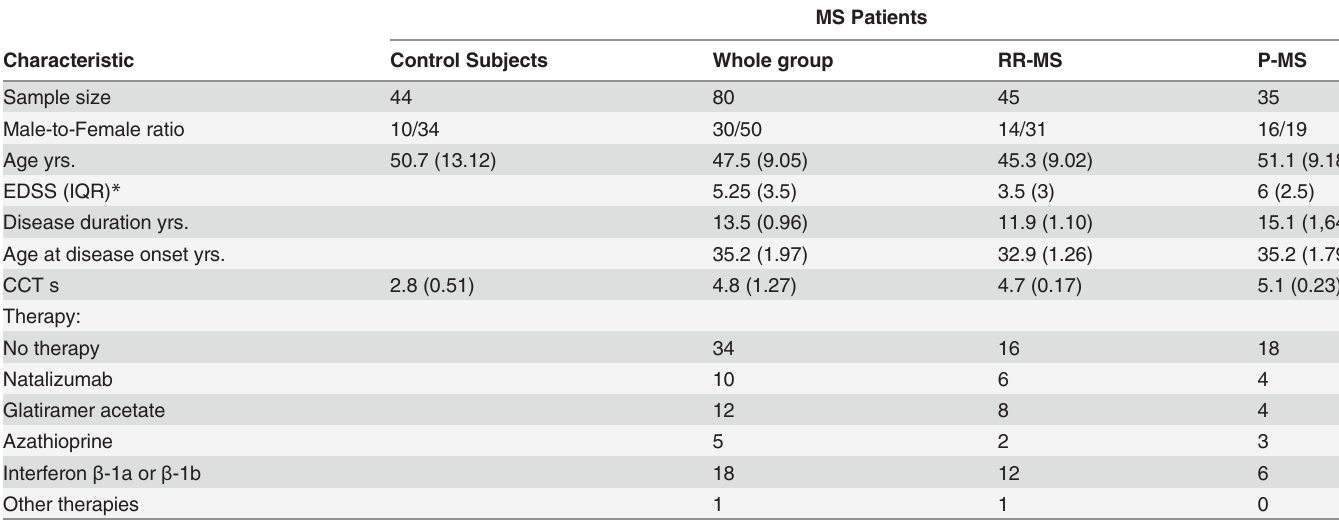
Table 1. Clinical Data and CCT values in MS patients and Control Groups.